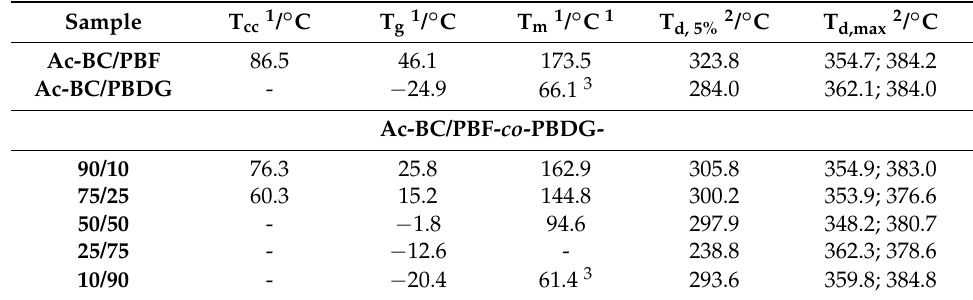
Table 1. Important thermal values obtained from differential scanning calorimetry (DSC) and thermogravimetric analysis (TGA)